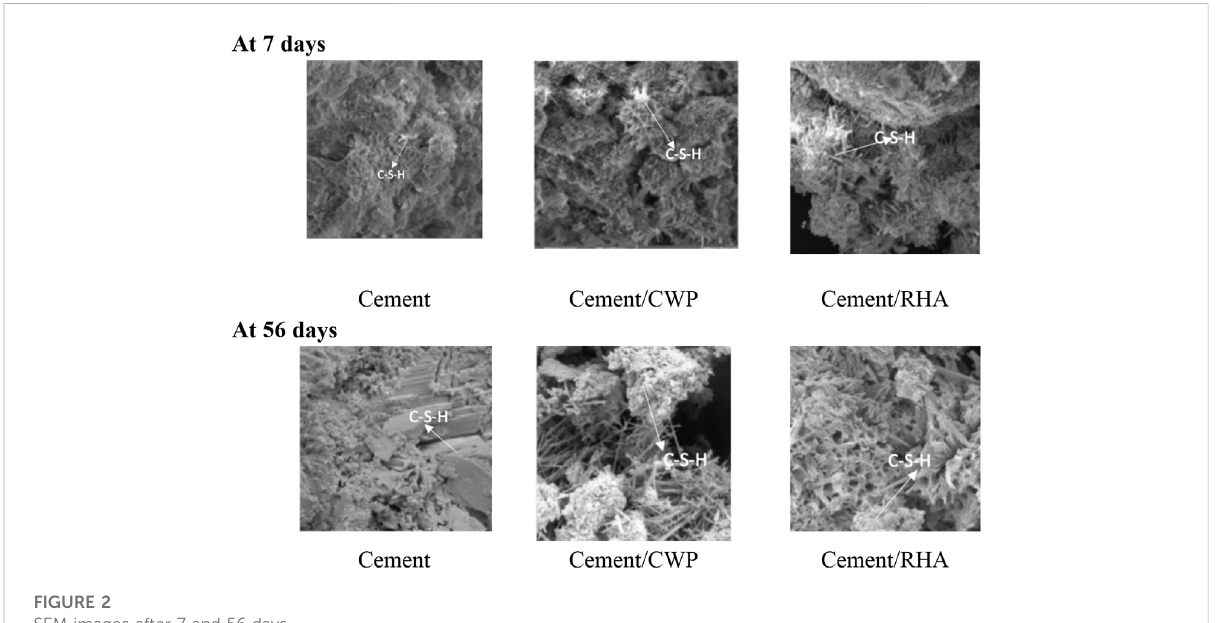
FIGURE 2 SEM images after 7 and 56